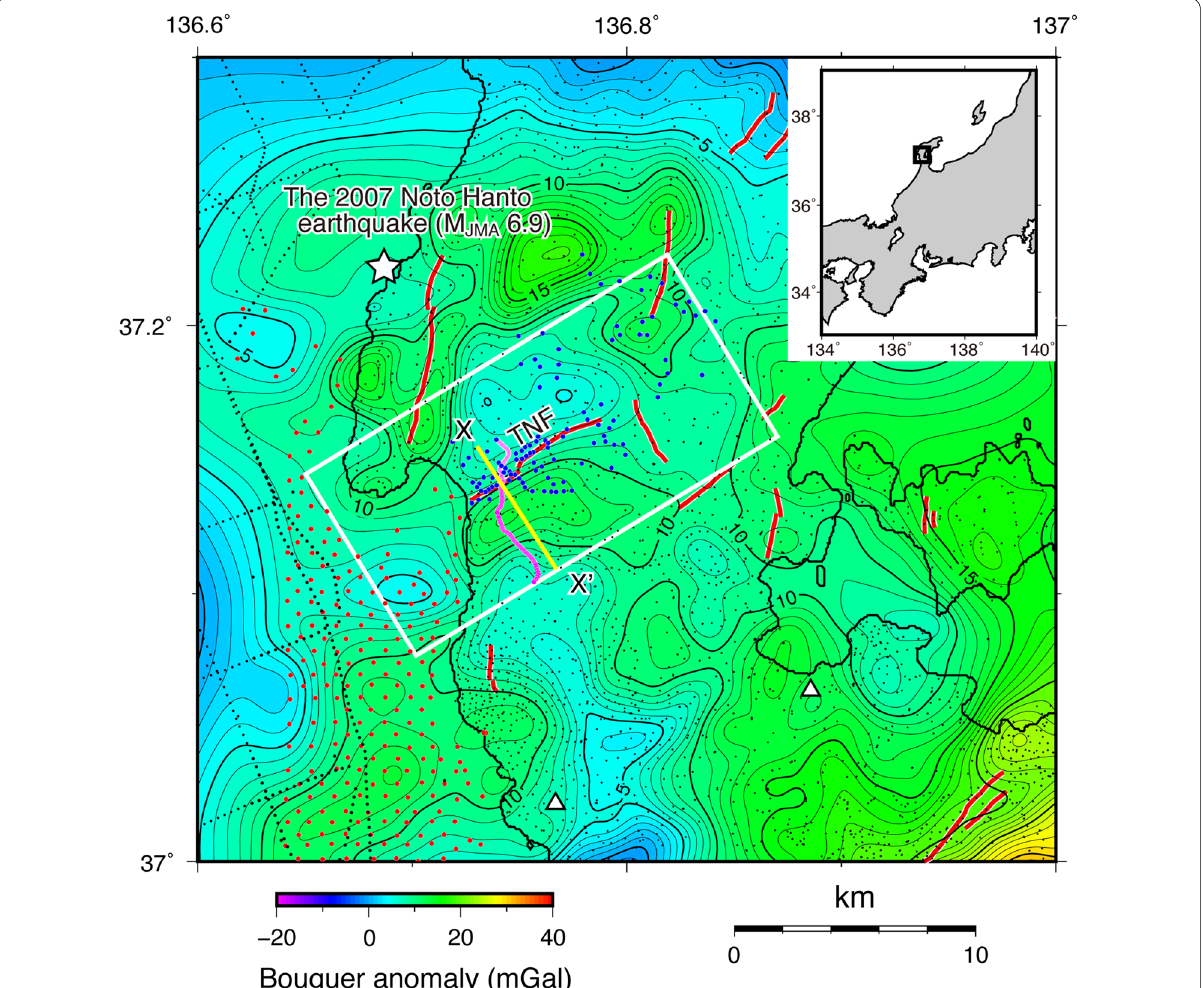
Fig. 1 Bouguer anomaly map around the Togi-gawa Nangan fault (TNF). Blue and purple, as a profile for the analysis of 2D density structure, circles represent the gravity measurements points of this study; red ones denote those on the seafloor reported by Ishida et al. (2018). Black dots are the gravity measurements points reported from previous studies (Geographical Survey Institute 2006; Yamamoto et al. 2011; Honda et al. 2012; Geological Survey of Japan 2013). White triangles represent the locations of deep drilling holes (Sutou et al. 2004). Red lines show active faults (Imaizumi et al. 2018). A yellow line is the line on which we estimated the 2D density structure using the 2D Talwani’s method as depicted in Fig. 3. A white star shows the epicenter of the 2007 Noto Hanto earthquake. A white rectangle shows the range of Fig.